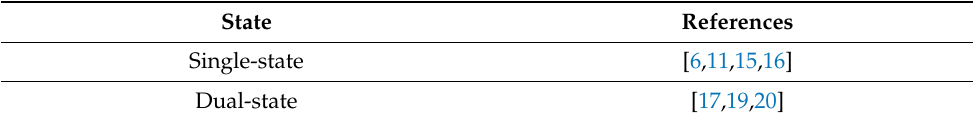
Table 1. Reviews about state estimation on the web of